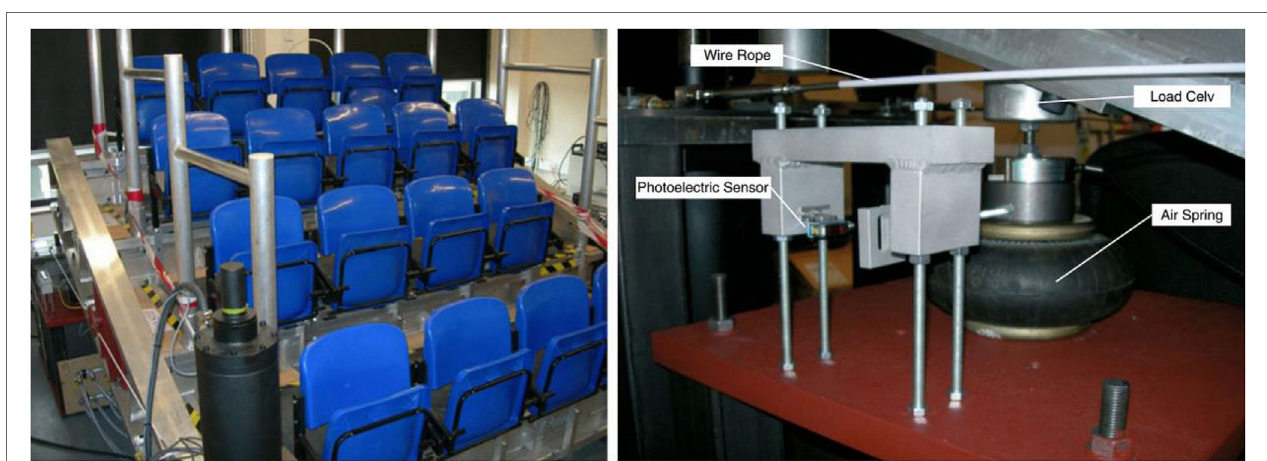
FiGURe 2 | The grandstand rig and the air spring assembly. Reprinted from (Comer et al., 2010) with permission from